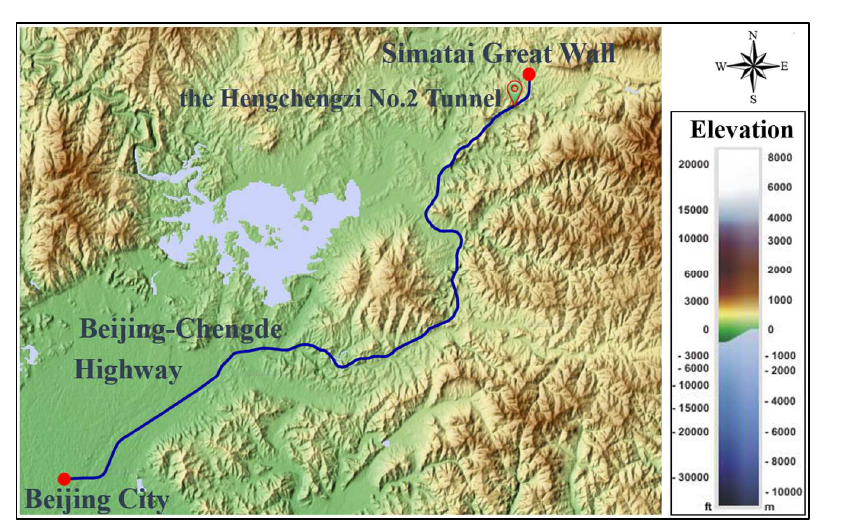
Figure 4. Rose map of wind direction and wind speed.